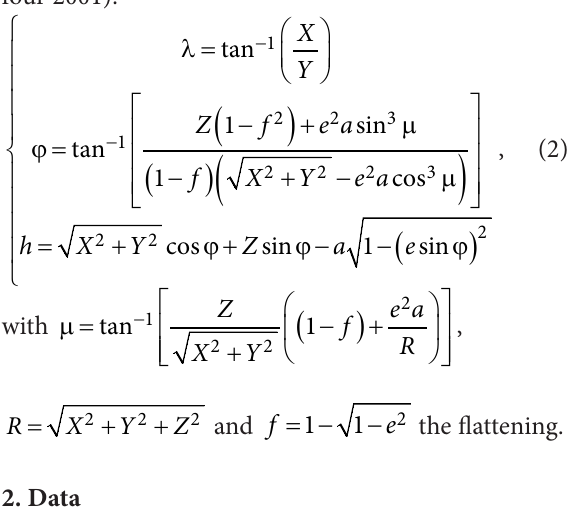
Fig. 2. Process of JICA-IGNN (JICA & IGN-N 1996) Table 1. Coordinates of the point no.65 on WGS84 released by